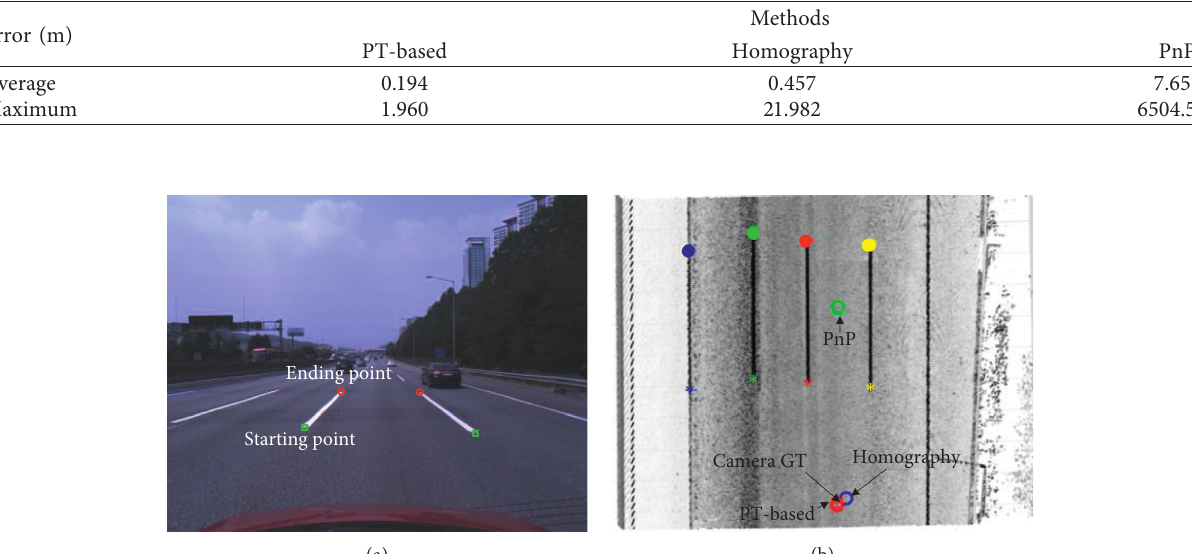
Table 3: Comparison of in-lane localizations with more than four lane endpoints.